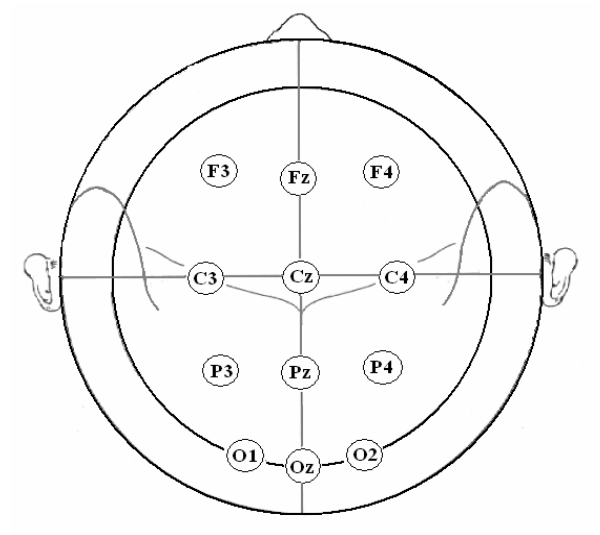
Figure 2. Electrode positions of